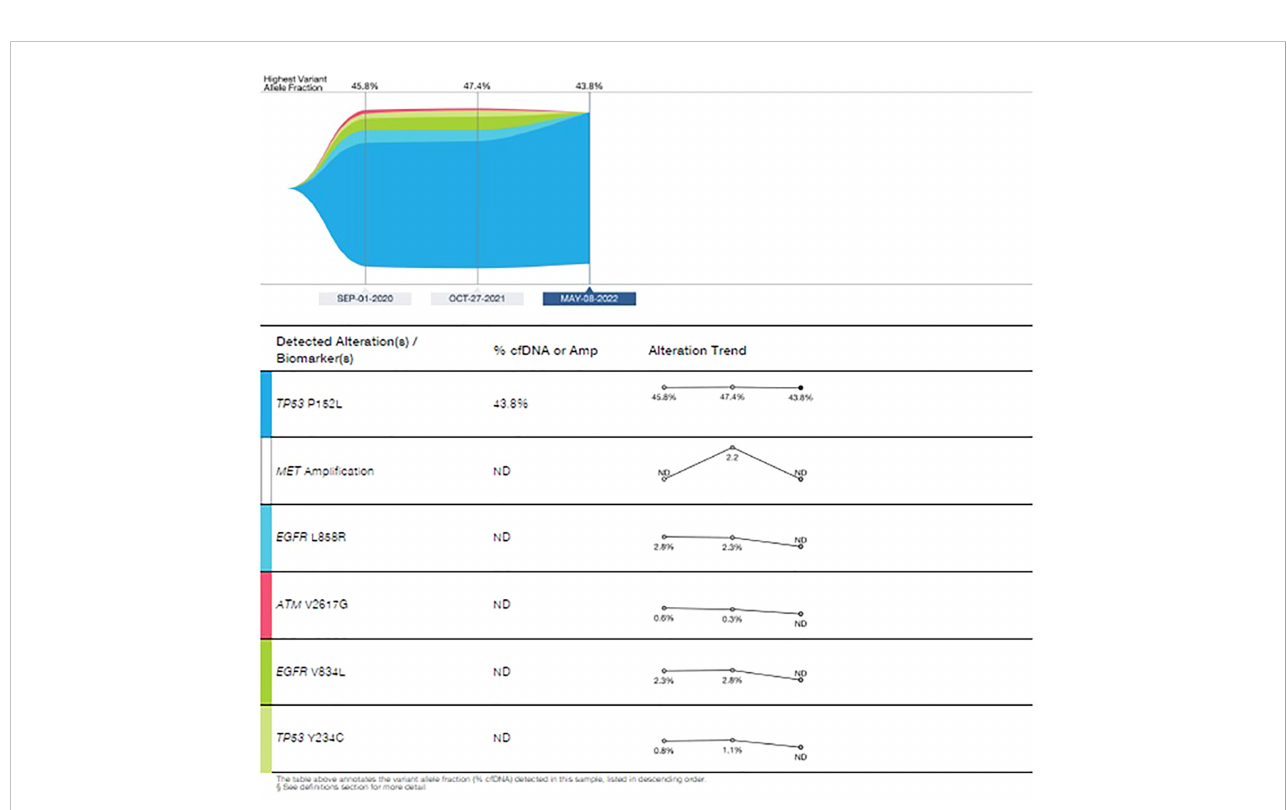
FIGURE 8 Guardant360 response map for circulating free tumor DNA following each treatment